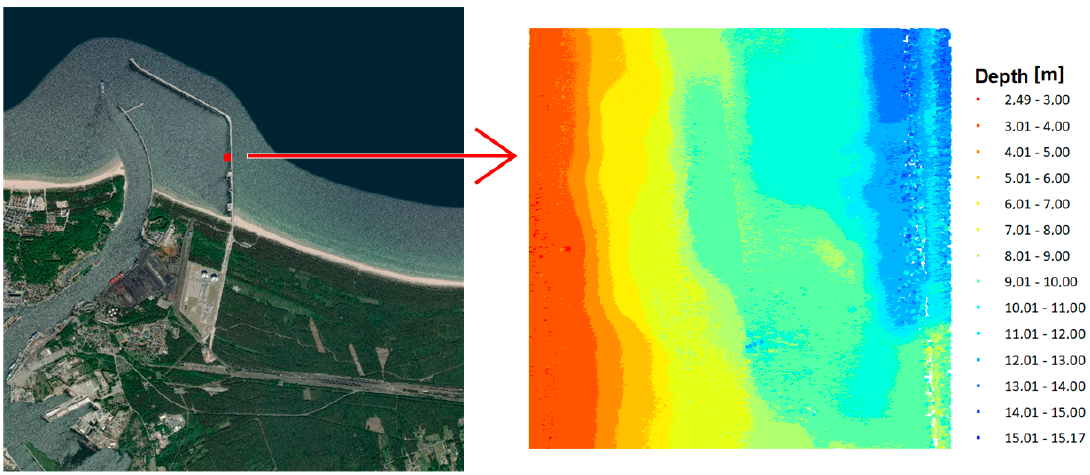
Figure 1. Test area no. 1—LNG port.